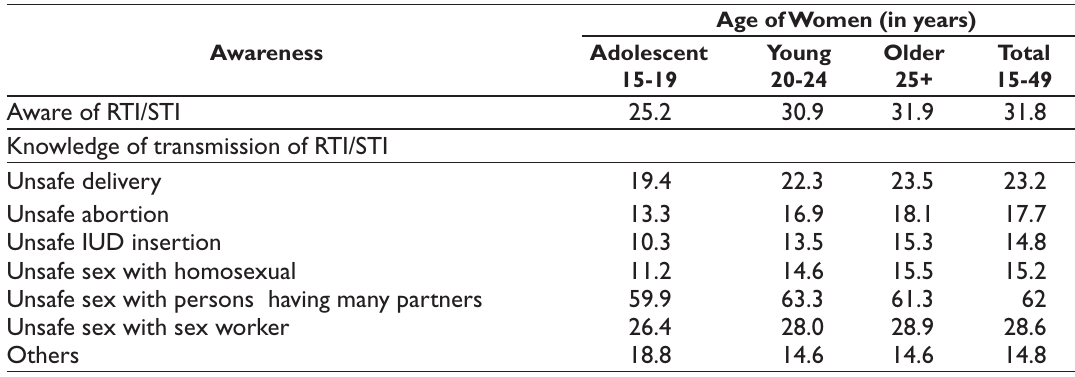
Knowledge of different mode of transmission of RTI/STI of ever married women by their age groups, India, 2007-08